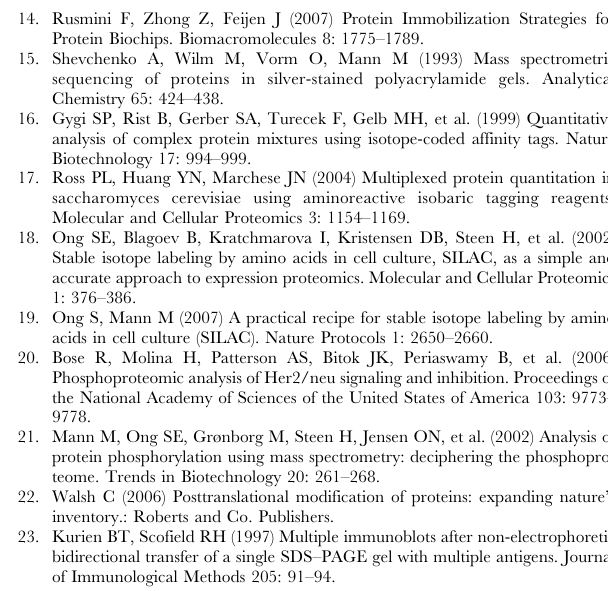
Figure S1 Characterizing Transfer Efficiency. (a) Protein transfer versus concentration. (b) Protein transfer versus electric field. (c) Protein transfer versus gel thickness. (d) Protein transfer versus time. (e) A sample image of serial dilutions transferred to an aminosilane slide. Figure S2 Gel transfer